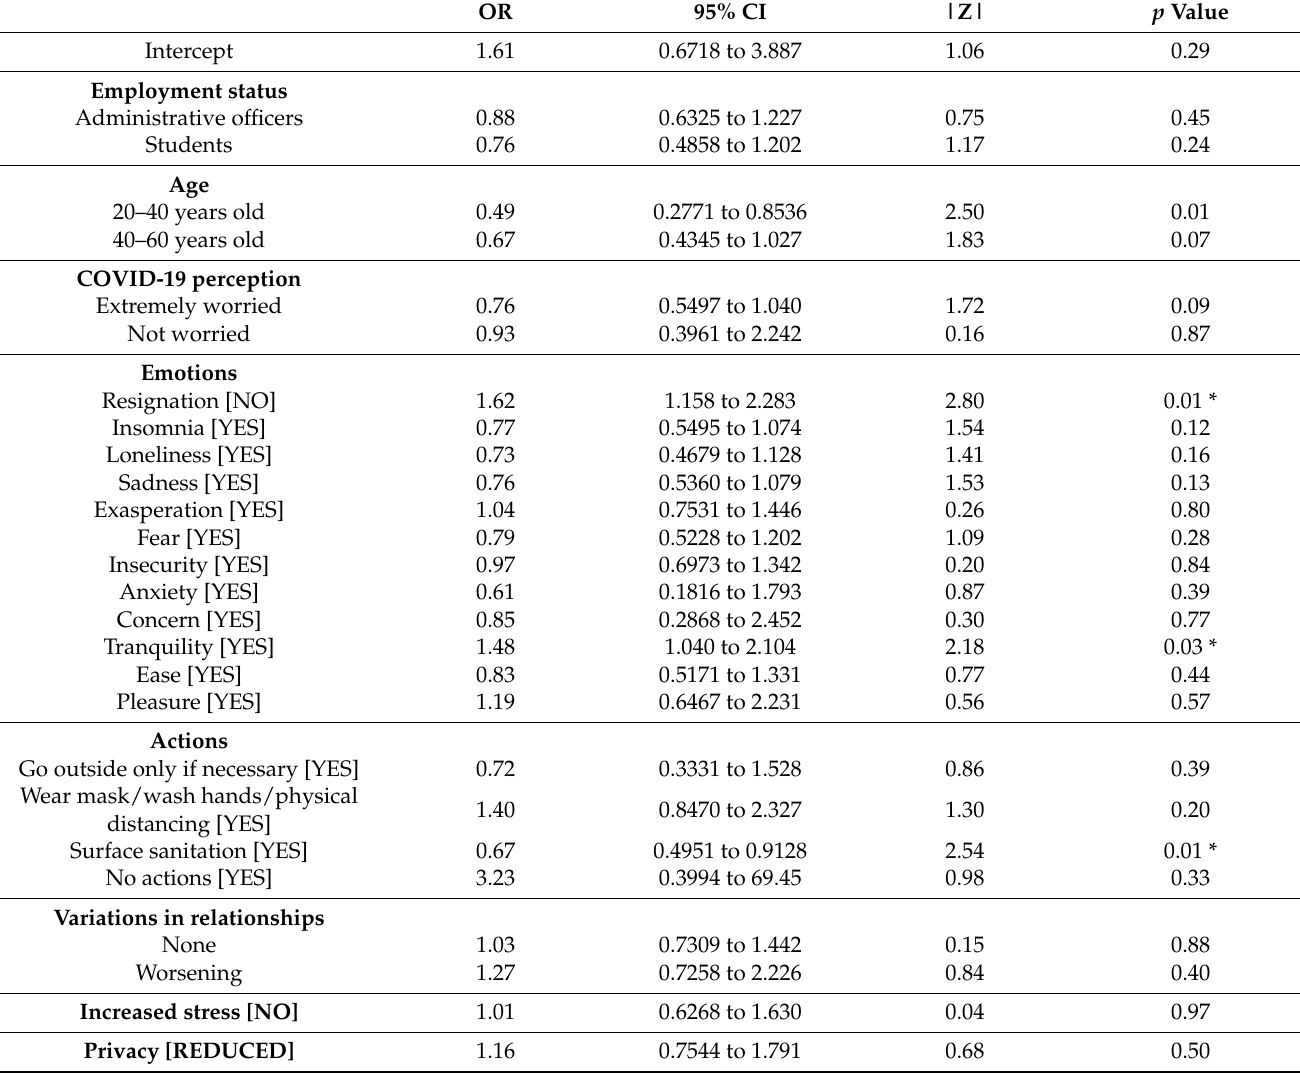
Table 5. Multivariate